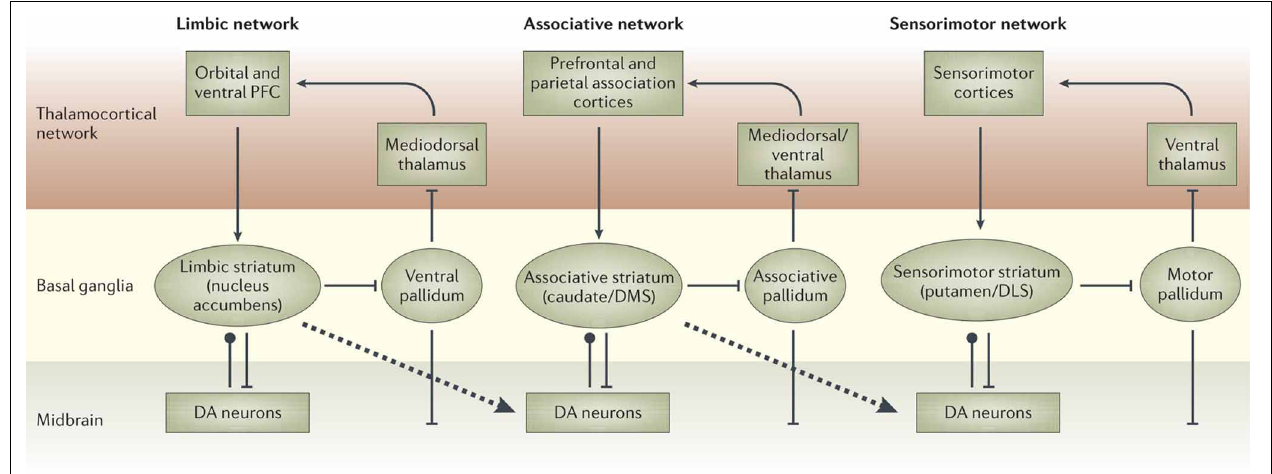
FIGURE 4 | The three main striato-cortical loops involving different territories of BG and cortical areas. Reprinted by permission from Macmillan Publishers Ltd: Nature Reviews Neuroscience (Yin and Knowlton, 2006), copyright